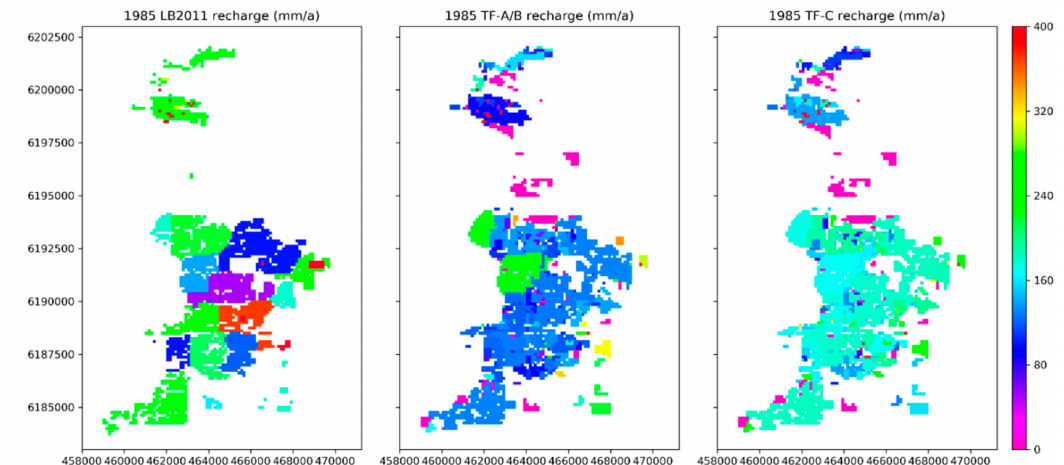
Figure 7. Distribution of irrigation recharge in 1985 within the existing LB2011 model, the TF-A / B model, and TF-C